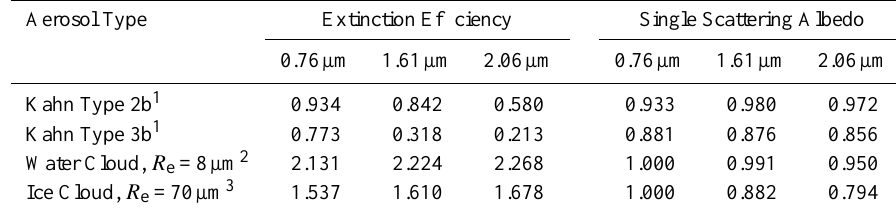
Table 3. Optical properties of cloud&aerosol types in retrieval state